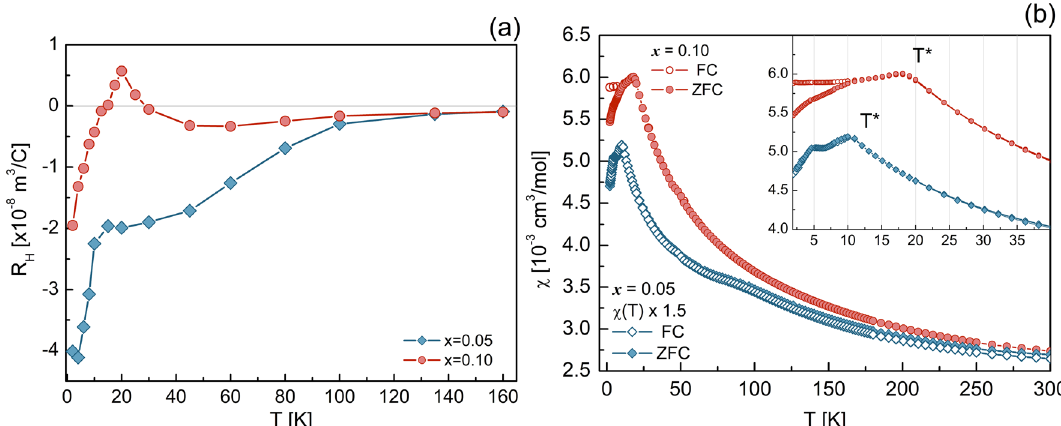
Figure 1. ( a ) Hall coefficient R H vs. T for the x = 0.05 (blue) and 0.10 (red) cases. See text for details. ( b ) DC magnetic susceptibility vs. temperature measured at 3 T in both zero-field-cooled (ZFC) and in field-cooled (FC) conditions. The full and open blue symbols refer to the x = 0.05 case, while the red symbols to x = 0.10 . To facilitate a comparison, the χ( T ) data for x = 0.05 were multiplied by a factor of 1.5. The inset highlights the low-temperature features, with the cusps and changes in slope indicating the magnetic transition of the iron- and samarium ions, respectively. Here, T ∗ indicates the magnetic anomaly induced by the Mn substitution (see text for